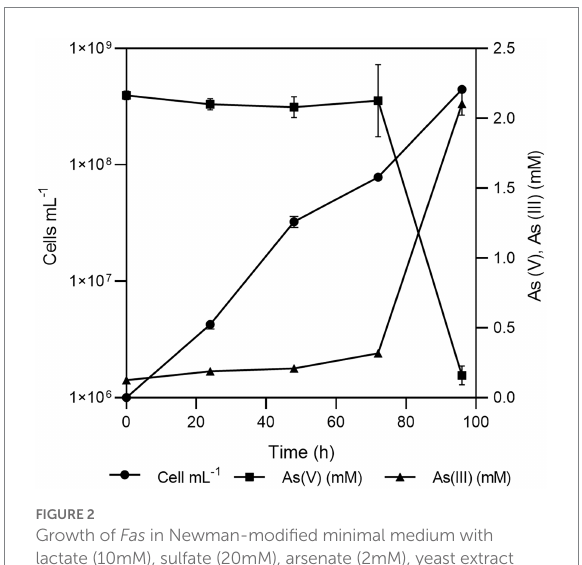
FIGURE 2 Growth of Fas in Newman-modified minimal medium with lactate (10 mM), sulfate (20 mM), arsenate (2 mM), yeast extract (0.1%), NaCl (10 g L-1), and cysteine (1 mM). Error bars represent the standard error of the mean of triplicate cultures. Sterile control experiments were also performed but the results were not shown for